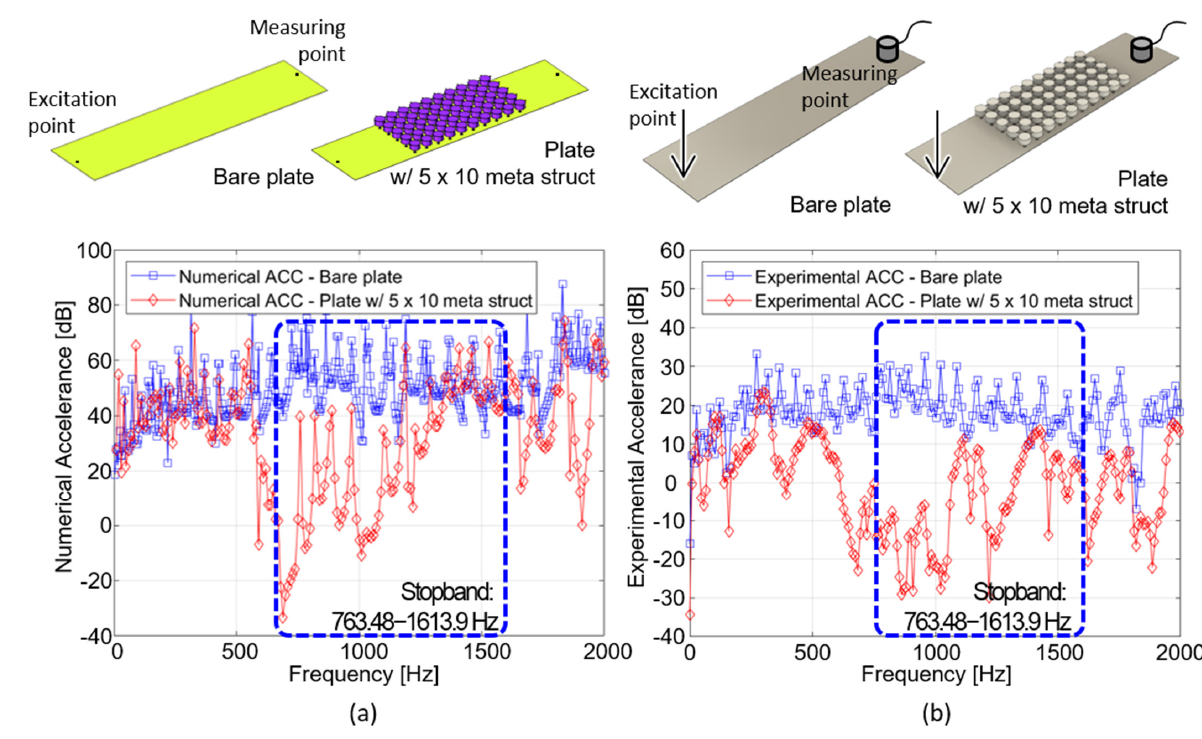
Figure 10. Accelerance transfer function between the excitation and measuring points in 1 T aluminum plates with/without the 5 × 10 interconnected metamaterials: ( a ) calculated form frequency response analysis and ( b ) measured by impact testing .